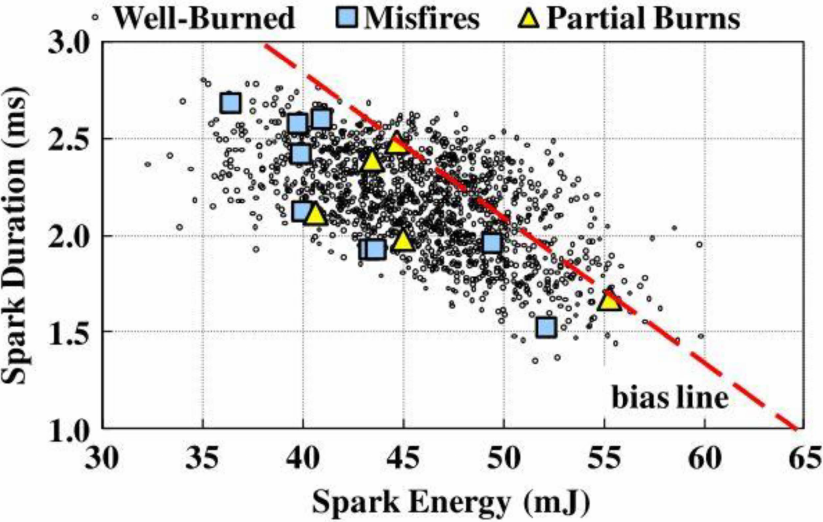
Figure 1. The range of spark duration and spark energy during well-burned, misfire, and partial burn cycles